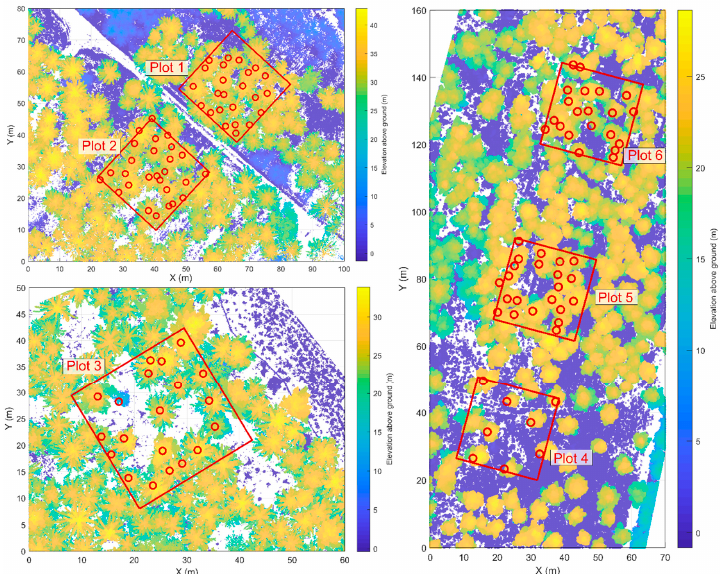
Figure 1. Location of six sample plots (red squares) and positions of measured trees (red circles). Colors in the maps express aboveground height according to the color bars.